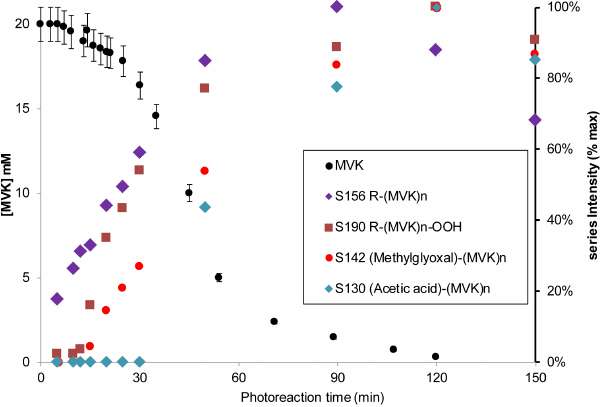
Fig. 11. MVK kinetics and time profile of main oligomers series (obtained using UPLC-ESI-MS, for the retention time range 0– 7min, in both modes) at 5 ◦ C. The series intensity is the sum of the peaks intensity. Each series intensity is expressed as a percentage of its